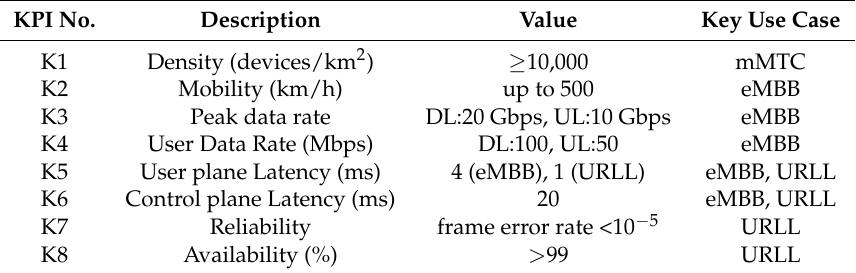
Table 1. KPIs to assess the performance of 5G use cases in the field trials.